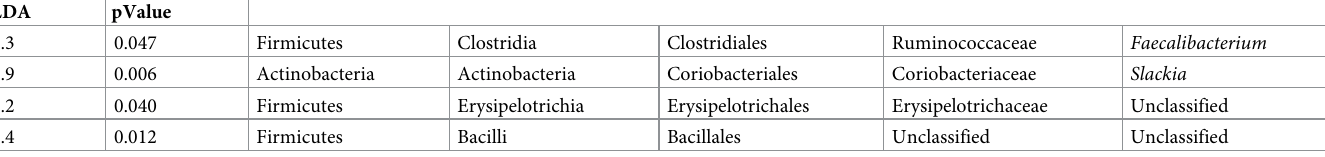
Table 4. LefSe of bacterial taxa and their association with the one-week post FMT samples, demonstrating taxa with an LDA > 2.